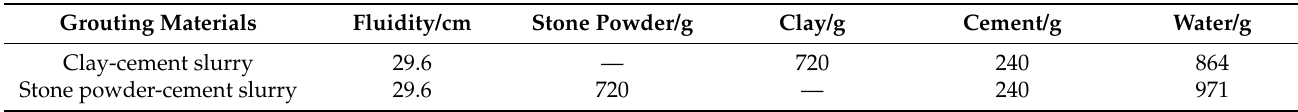
Table 3. Mixing ratio of grouting